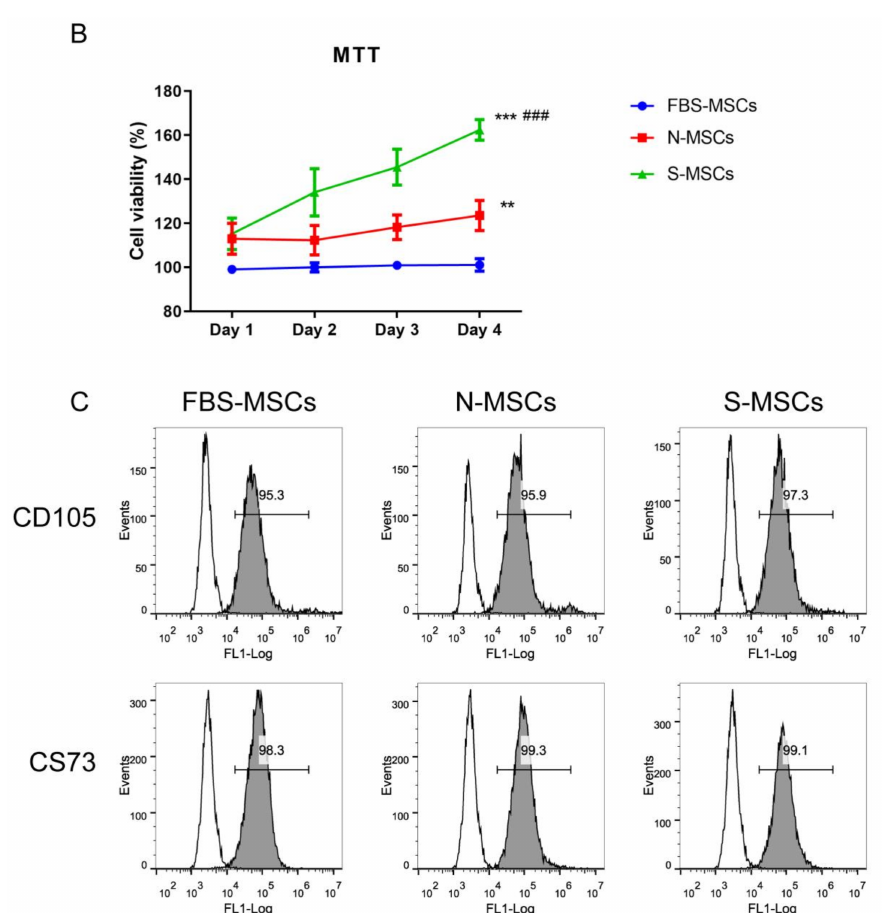
Figure 1. Characteristics of Mmesenchymal stem cells (MSCs): ( A ) Morphological characteristics of MSCs (Scale bar = 100 µ m); ( B ) MTT test of MSCs’ viability. Cells were cultured and optical density was serially monitored at 540 nm ( x ± s , n = 3); ( C ) Flow cytometric analysis of MSC surface markers, CD73 and CD105 of MSCs. ** p < 0.01, N-MSCs treated group versus FBS-MSCs group. *** p < 0.001, S-MSC-treated group versus FBS-MSCs group. ### p < 0.001, S-MSC-treated group